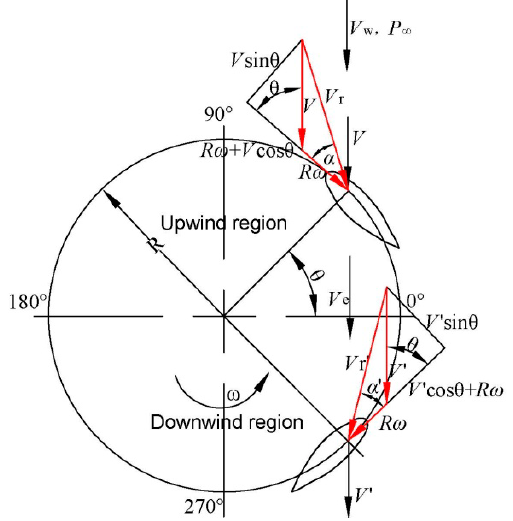
Figure 2. Relative wind speed vectors in the upstream and downstream section. Appl. Sci. 2018 , 8 , x